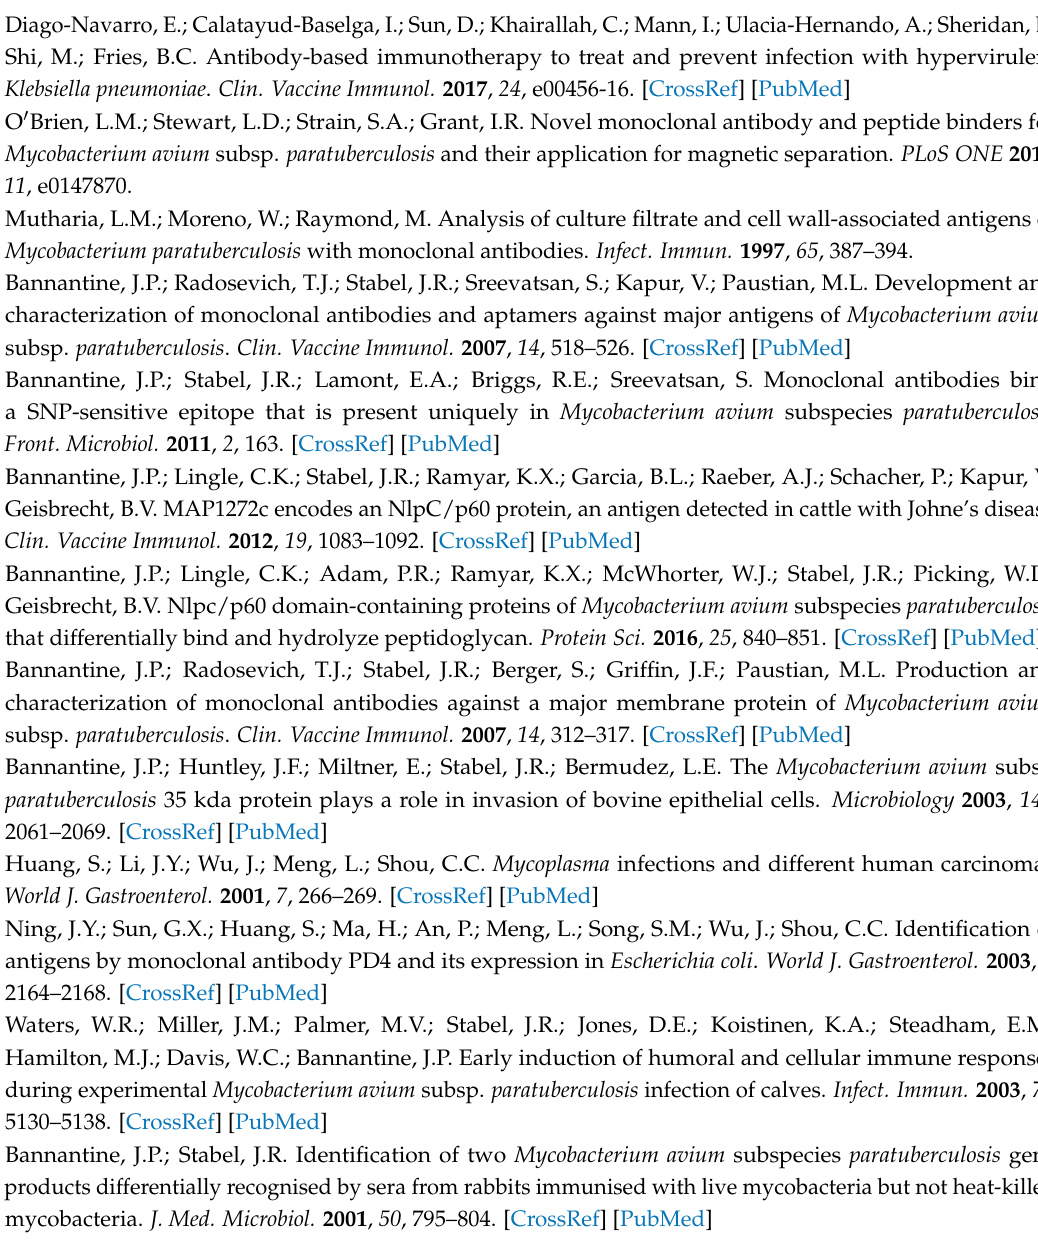
mAb 6C9 binds to MAP_3060c, Figure S3: The antigen that binds 12C9 was captured in a specific manner, Figure S4: Location of antibody epitopes to the MAP_3936 groEL2 protein, Figure S5: MAP_3404 epitope mapping using an overlapping peptide array, Figure S6: Location of the 12C9 antibody epitope to the center region of MAP_4145, Table S1: Recombinant protein assignments on the dot blot array shown in Figure 2B, Table S2: Peptide library sequences and spot/well locations for MAP_2698c and MAP_3404, Table S3: Monoclonal antibody reactivity to mycobacterial